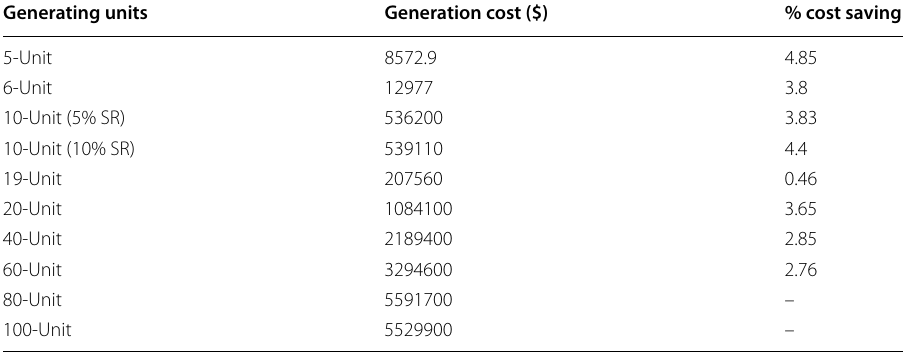
Table 23 Overall cost for generation of each unit with renewable energy sources in winter Generating units